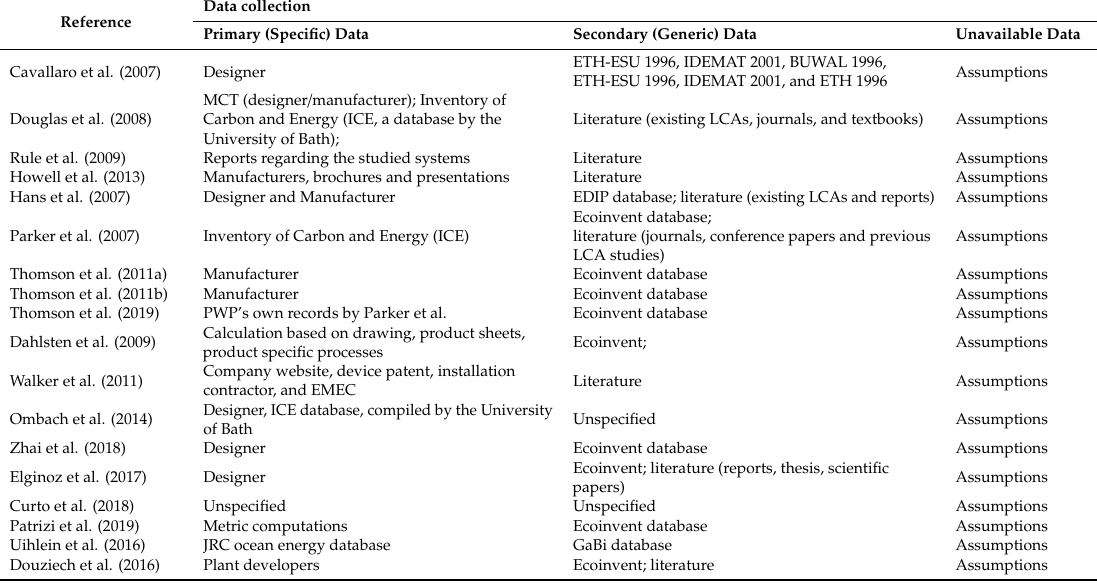
Table 3. Data collection sources for studied